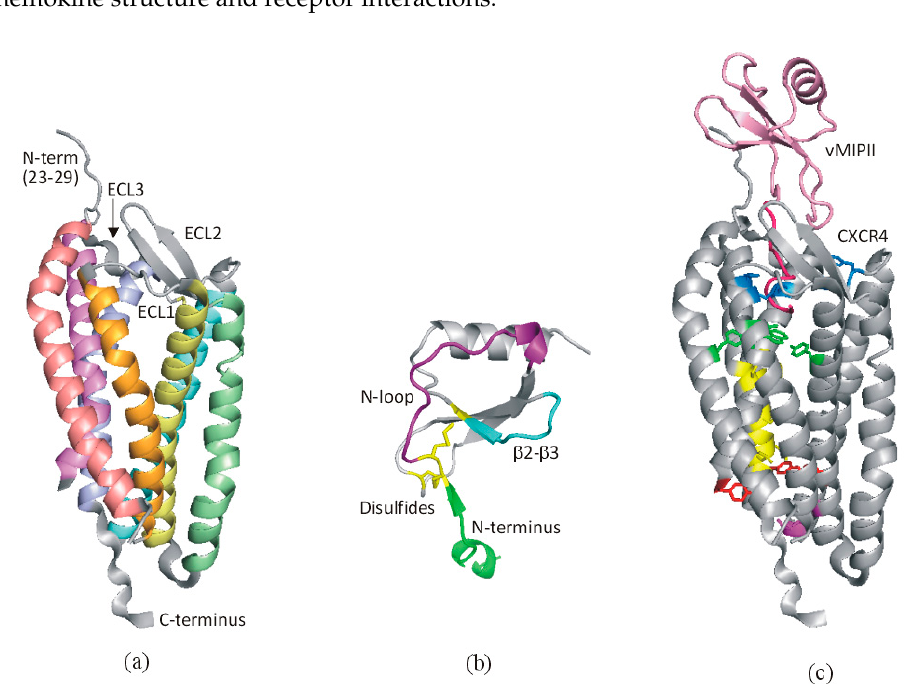
Figure 3. Structural basis of chemokine-receptor recognition. ( a ) One monomer unit of the receptor CXCR4 (PDB code 4RWS [14]) with extracellular regions labeled; transmembrane helices are colored salmon (I), orange (II), yellow (III), green (IV), turquoise (V), violet (VI), and magenta (VII). ( b ) A typical chemokine monomeric unit (CCL2/MCP-1, PDB code 1DOK [18]) highlighting the critical regions for receptor recognition. ( c ) Structure of CXCR4 bound to vMIPII (PDB code 4RWS [14]) showing the chemokine in pink (N-terminal region in hot pink) and the receptor in gray, with residues proposed to be involved in transmembrane signaling [19] colored according to their putative roles: blue, chemokine engagement; green, signal initiation; yellow, signal propagation; red, microswitch residues; magenta, G protein coupling. In panels ( a , c ) residues 1-22 are not shown as they were not modeled in the crystal structure.